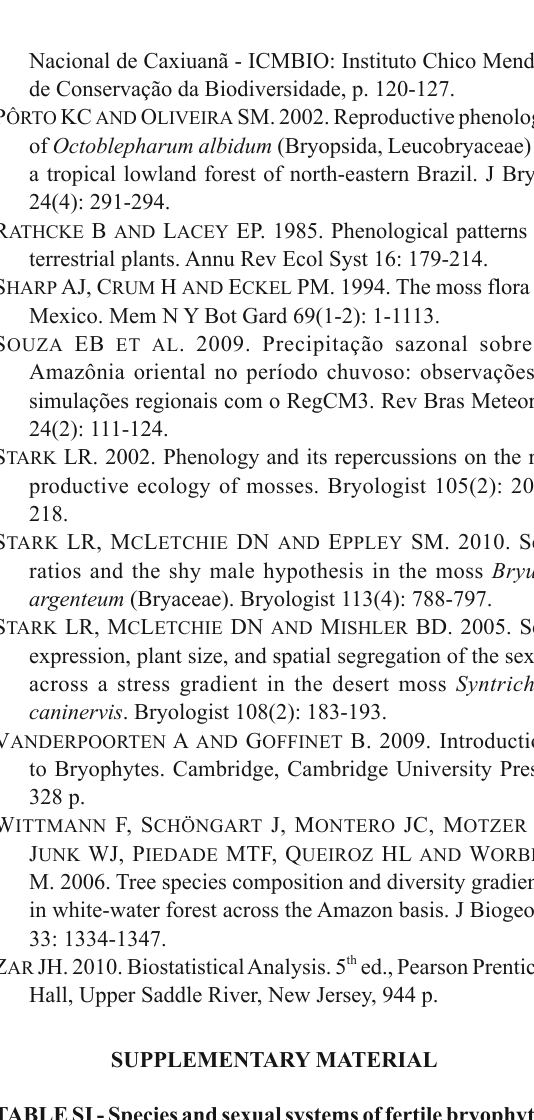
TABLE SI - Species and sexual systems of fertile bryophytes at igapó and várzea forests during the periods of lower and higher precipitation (dry and rain). D = dry; R = rain; V = Várzea ; I = Igapó ; X = presence of reproductive